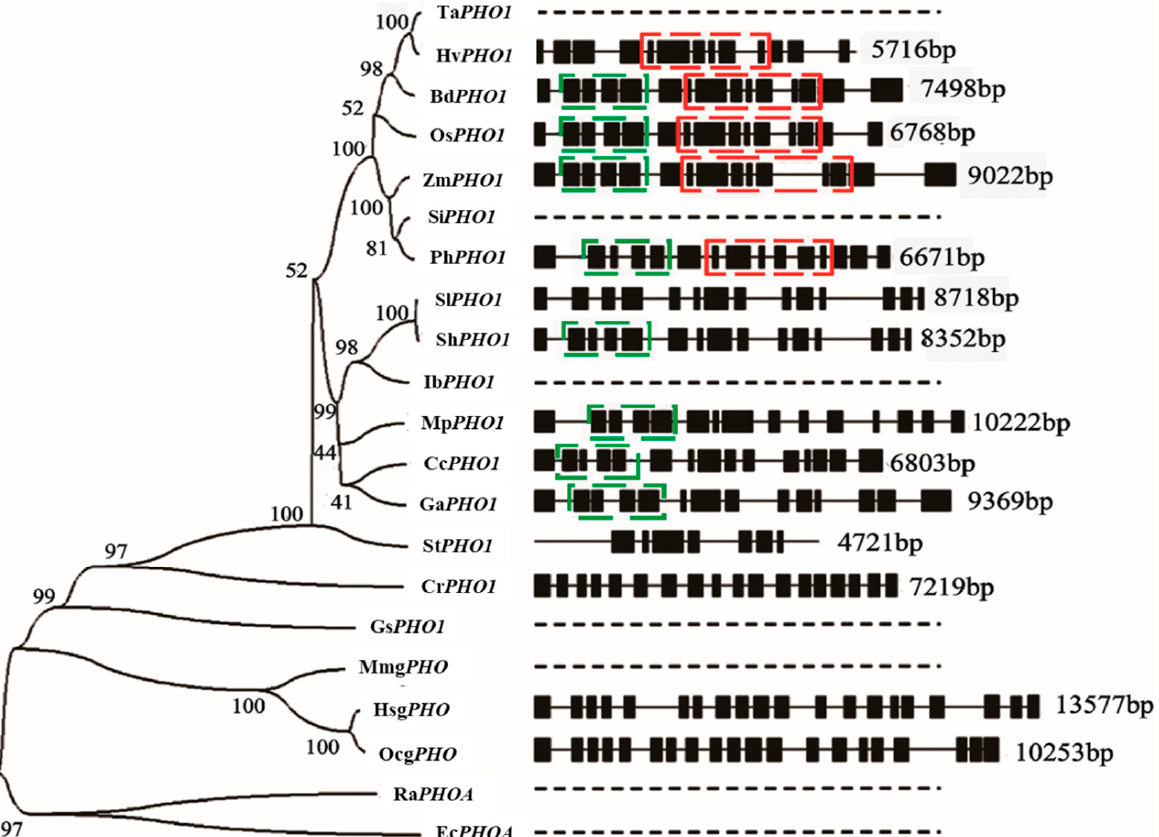
Figure 2. Phylogram showing the evolutionary pattern of PHO1 , g PHO , and maltodextrin forms of phosphorylases and gene structures with common exon–intron junctions among a wide range of species. The tree was generated by MEGA 7 with the neighbor-joining method [83]. The bootstrap value is calculated based on 1000 repetitions and displayed on each node. Abbreviations: Ta: Triticum aestivum , Hv: Hordeum vulgare , Bd: Brachypodium distachyon , Os: Oryza sativa , Zm: Zea mays , Si: Setaria italica , Ph: Panicum halli , Sl: Solanum lycopersicum , Sh: Solanum habrochaites , Ib: Ipomoea batatas , Mp: Mucuna pruriens , Cc: Citrus clementina , Ga: Gossypium arboreum , St: Solanum tuberosum , Cr: Chlamydomonas reinhardtii , Gs: Galdieria sulphuraria , Mm: Mus musculus , Hs: Homo sapiens , Oc: Oryctolagus cuniculus , Ra: Rhizobium anhuiense , and Ec: Escherichia coli . Gene annotations with varying bp (base pairs). Green and red boxes are showing the common intron–exon junctions with identical intron phases (presenting highly conserved regions among phosphorylases in range of species) in the given gene structures. Dashed lines indicate the limited or uncharacterized gene structures. Table 1. Proposed motifs in 2 kb upstream region of transcription start site in PHO1 of Zea mays , Oryza sativa , Hordeum vulgare , Triticum aestivum , and Arabidopsis thaliana . Motif Sequence Possible Function and DB ID aBrelaterD1 ACGTG ABA, drought, and dark-induced regulation (S000414) BIHD1OS TGTCA Disease resistance (S000498)